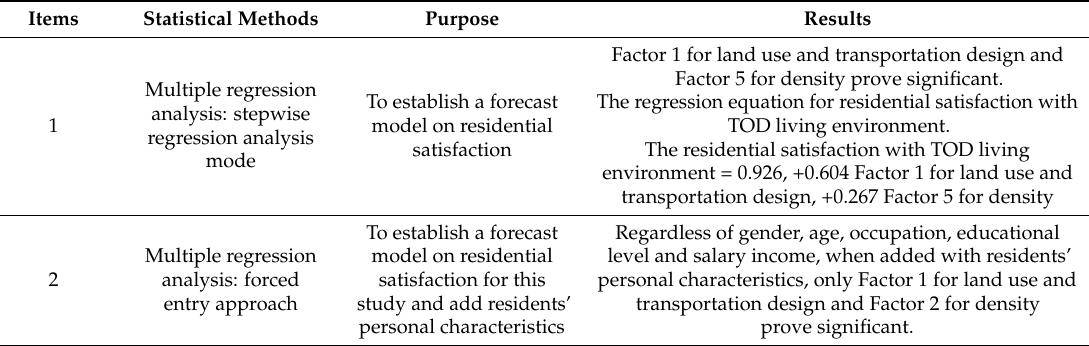
Table 8. Study findings for residents’ satisfaction with TOD living environment